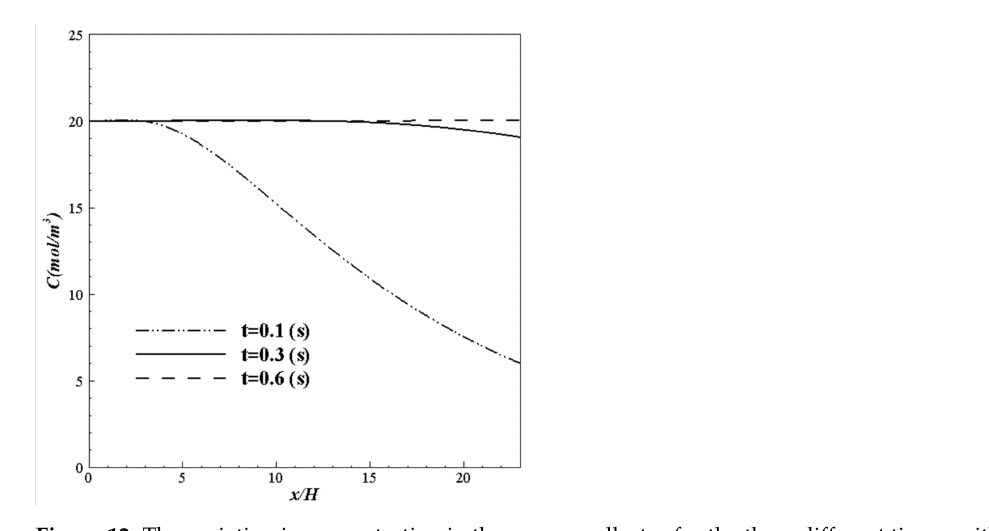
Figure 12. The variation in concentration in the porous collector for the three different times, with a low porosity coefficient of 0.2.